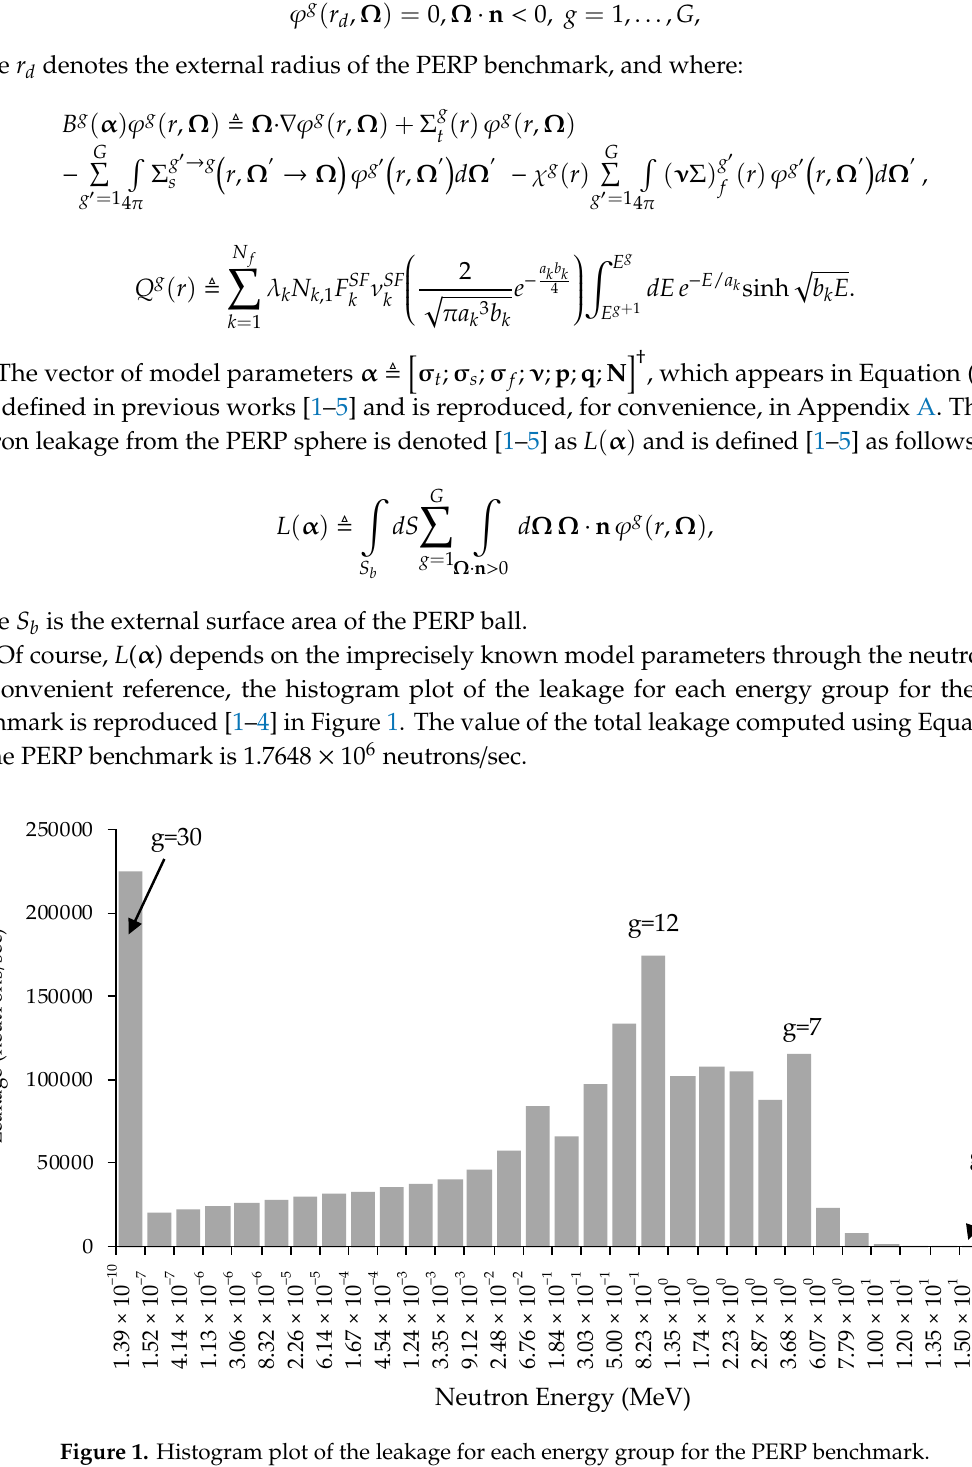
Figure 1. Histogram plot of the leakage for each energy group for the PERP benchmark.